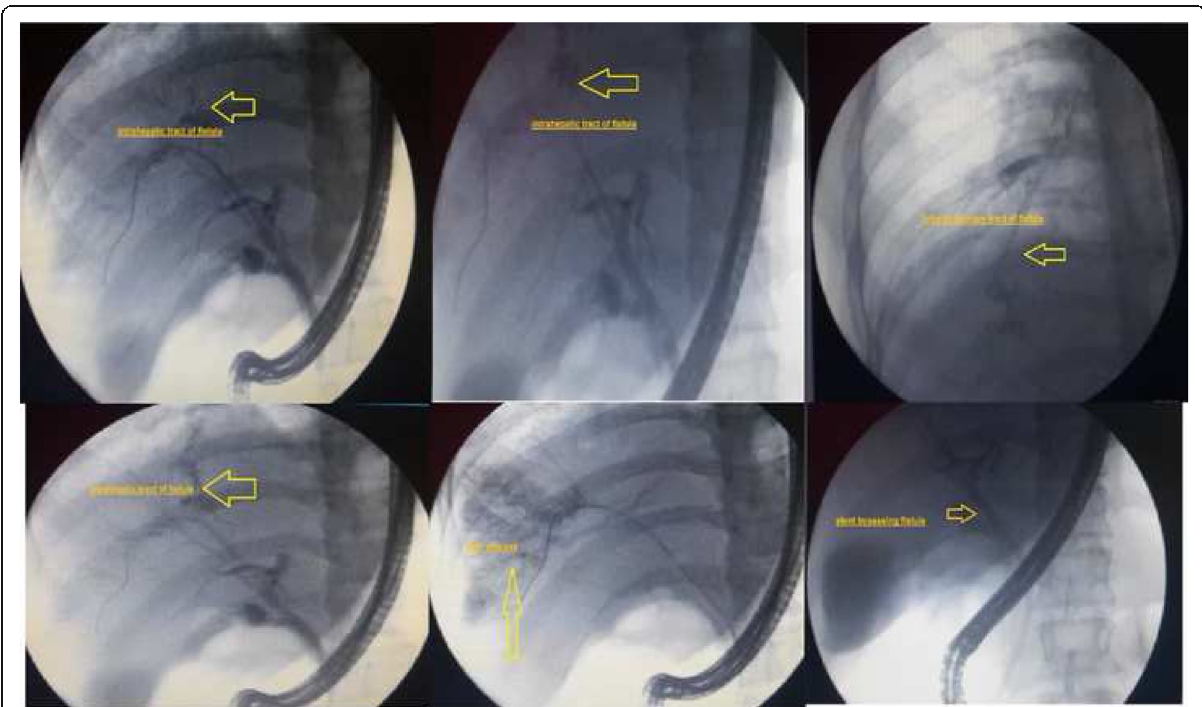
Fig. 2 ERCP fluoroscopic picture showing the abscess, the bronchobiliary fistula, and the biliary